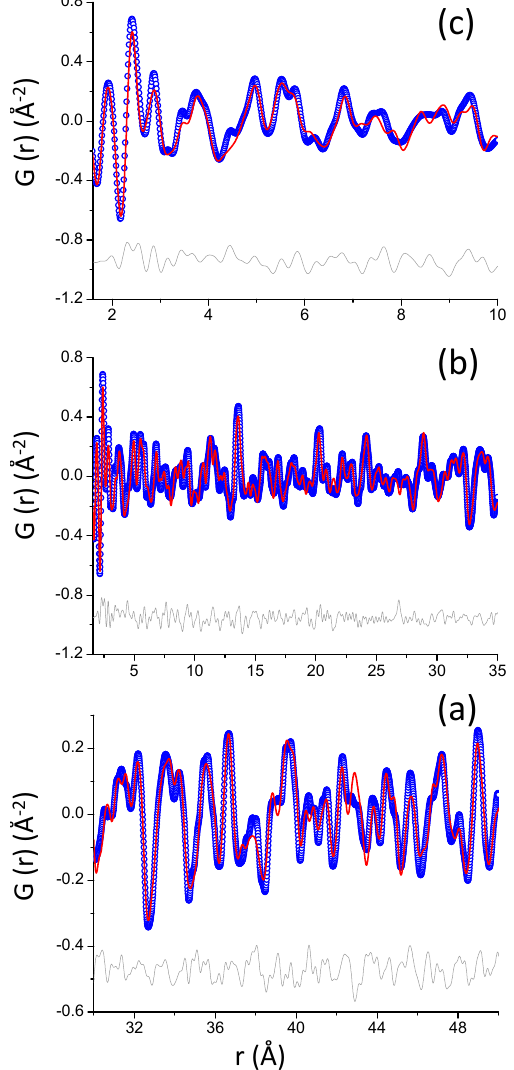
Figure 7. Experimental (blue circles) and fitted (red solid line) PDF patterns for the ye’elimite with gypsum paste hydrated with w/s = 1.20 for 21 days at room temperature ( a ) high r-range: 30–50 Å, ( b ) low r-range: 1.6–35 Å, ( c ) enlarged view of: 1.6 to 10 Å. Difference curves are shown as grey lines.